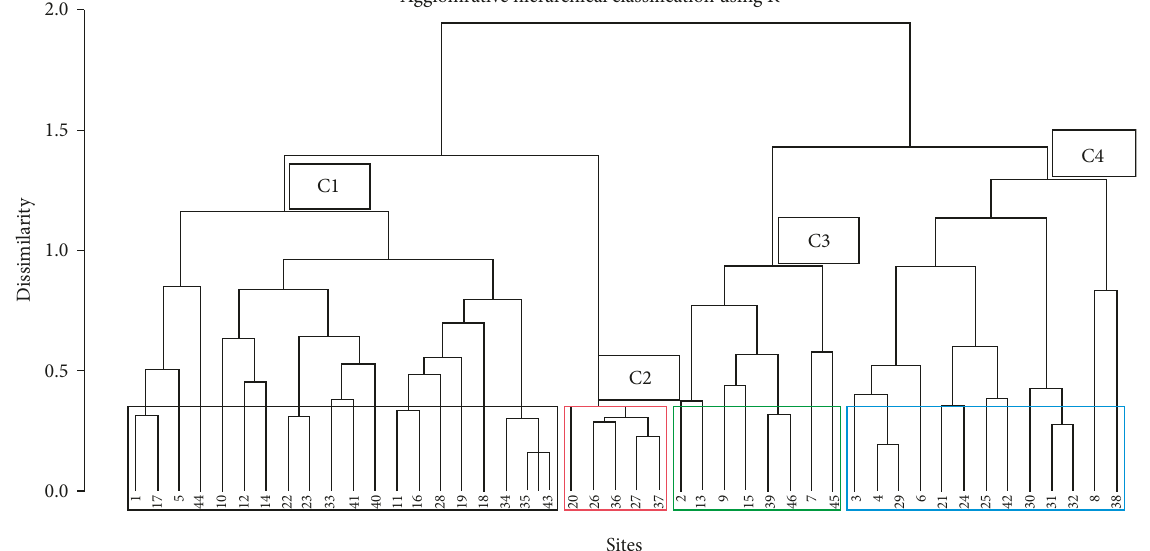
Figure 3: Dendrogram of the clusters (community types) of the Gennemar natural forest.